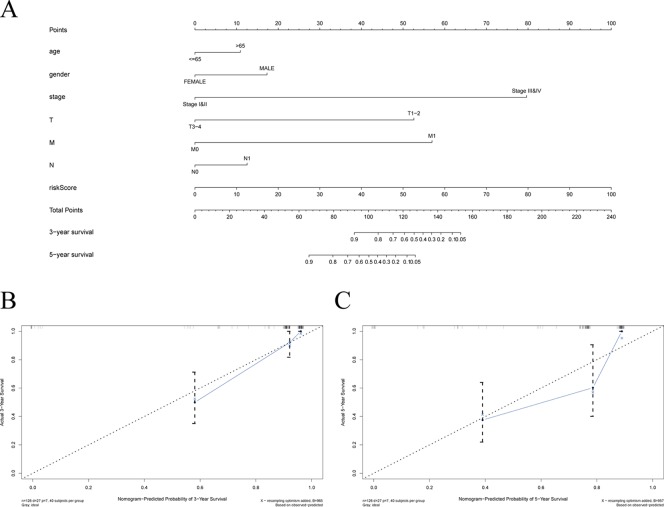
Establishment of the overall survival (OS) nomogram for papillary renal cell carcinoma (pRCC) patients based on alternate acceptor (AA) event. (A) Nomogram for predicting OS of pRCC. There were seven factors containing age, gender, stage, T, N, M, and riskscore in the nomogram. Each of them generates points according to the line drawn upward. And the total points of the seven components of an individual patient lie on “Total Points” axis which corresponds to the probability of 3-year and 5-year OS rate plotted on the two axes below. (B–C) The calibration plots for predicting patient 3‐ or 5‐ year OS.